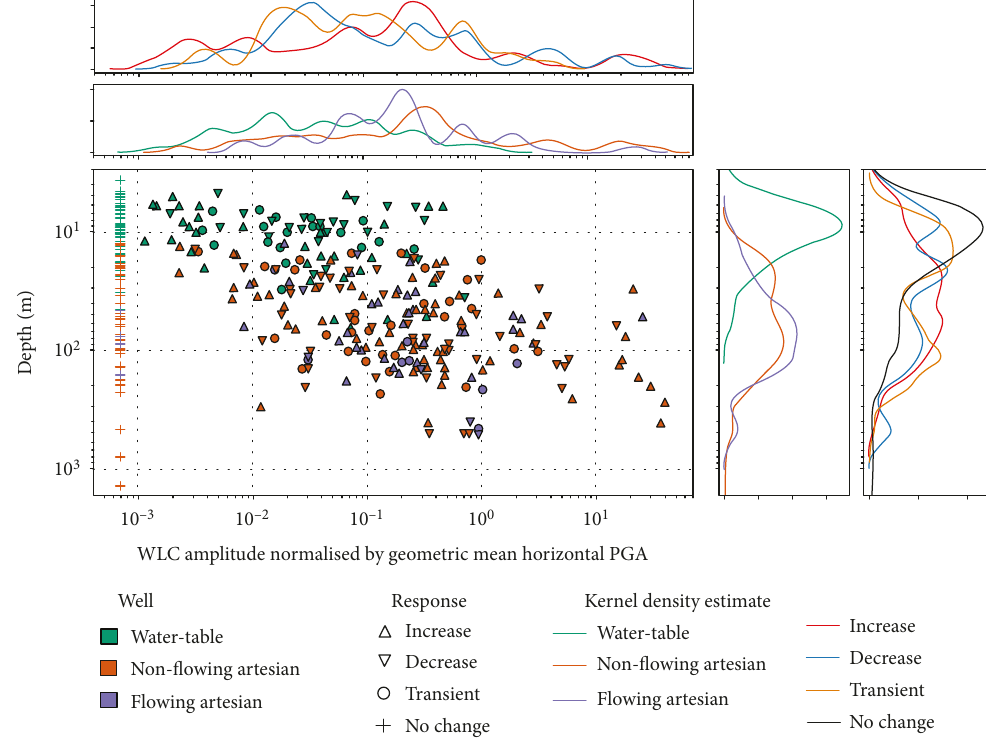
Figure 9: WLC/PGA as a function of monitoring well depth. Coloured according to monitoring well type (water-table, non fl owing artesian, and fl owing artesian). The deeper the monitoring well, the more sensitive the well was to water level change. All types of water level response (increase, decrease, transient, and no change) were observed over the entire depth range. Artesian wells commonly show water level increases at high